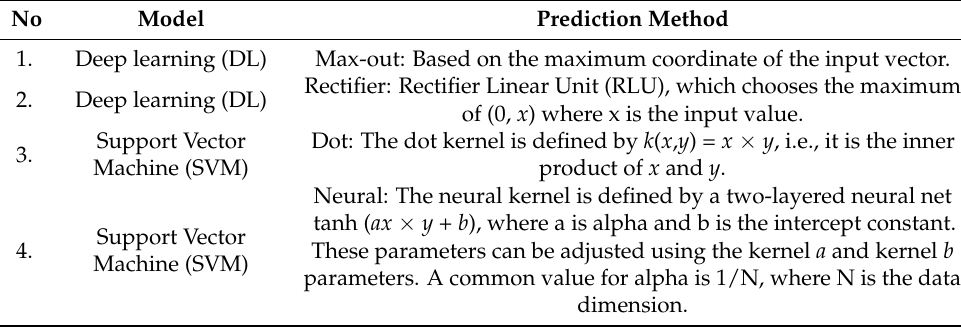
Table 3. The details of four prediction